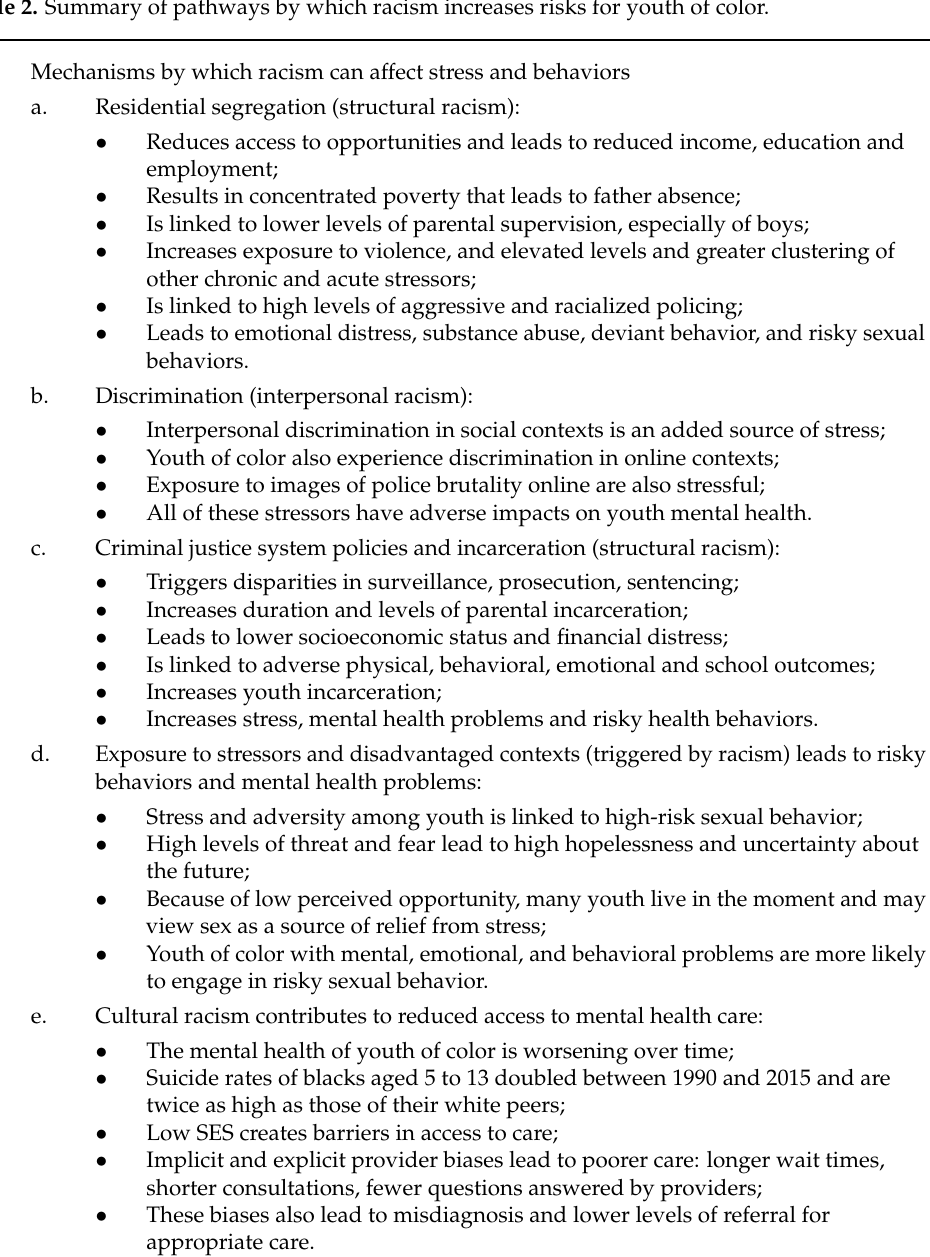
Table 2. Summary of pathways by which racism increases risks for youth of